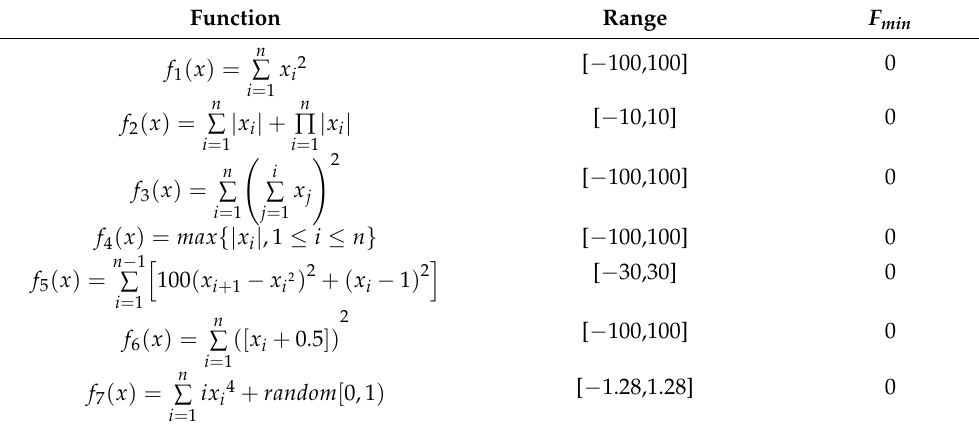
Table 2. Seven high-dimensional single objective functions (Dim =